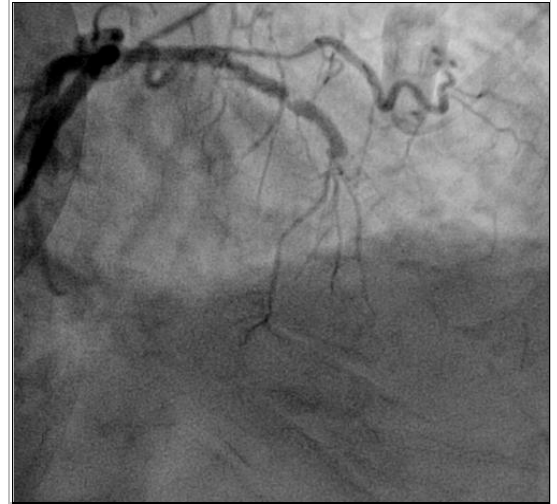
Figure 3. Coronary angiography at readmission in the patient case described in the case vignette. Subacute stent thrombosis, with a total vessel occlusion in the left anterior descending coronary artery three days after the percutaneous coronary intervention (PCI) illustrated in Figure 2.